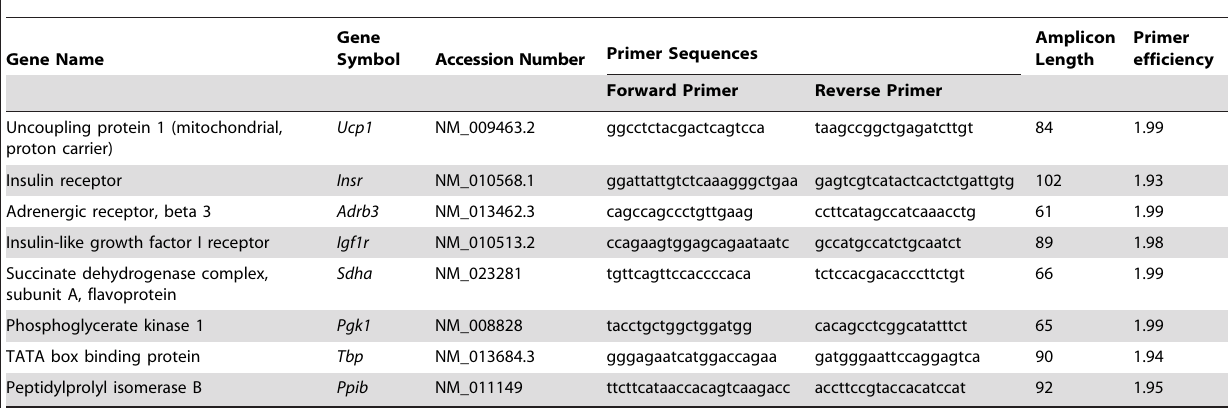
Table 5. Real-Time PCR primer details for gene expression studies.